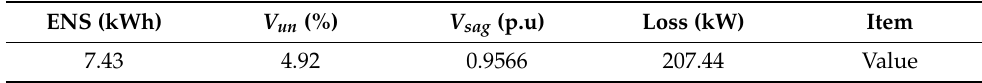
Table 2. The results of base unbalanced IEEE 33-bus distribution network.